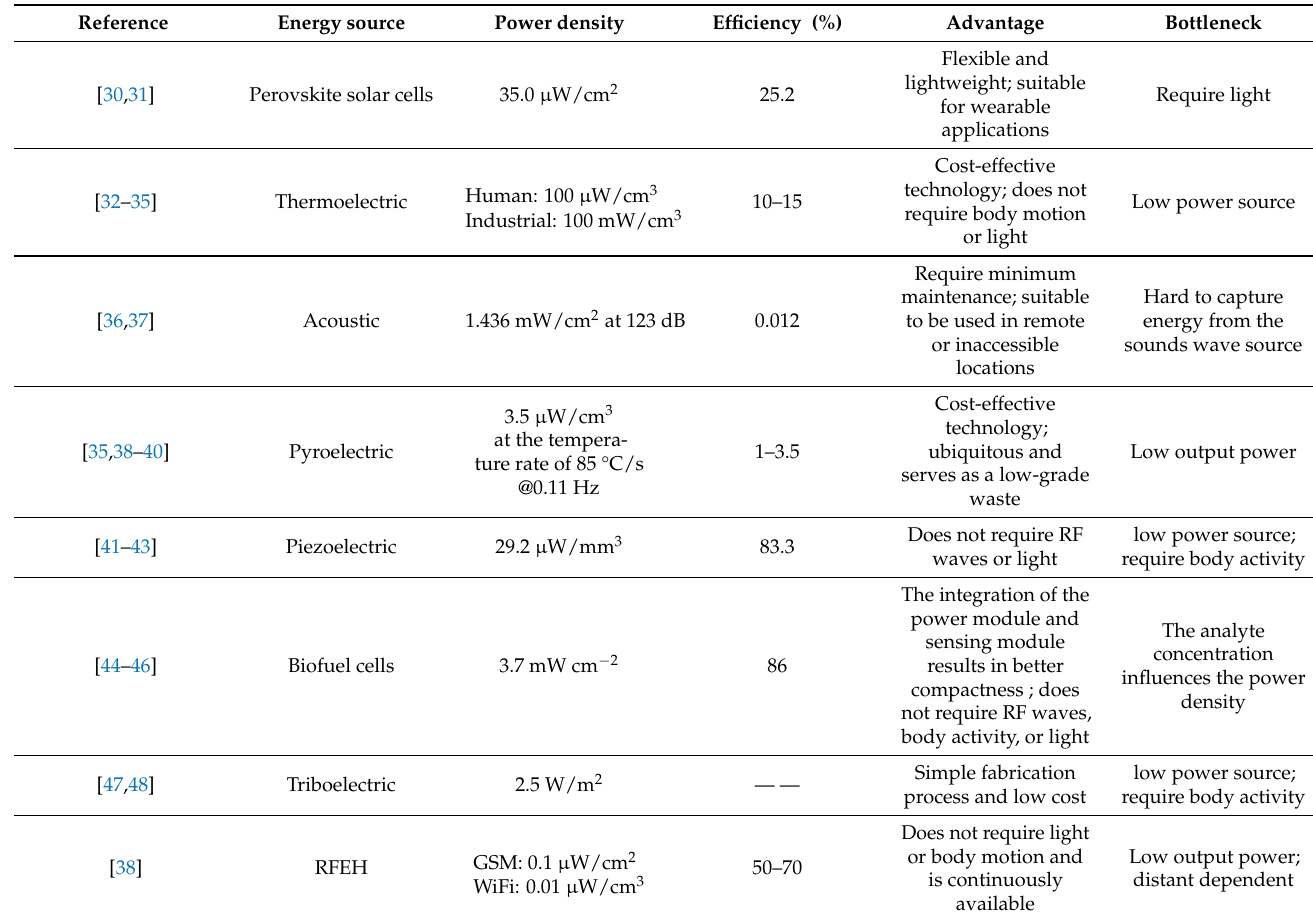
Table 1. Characteristics of various sources for energy